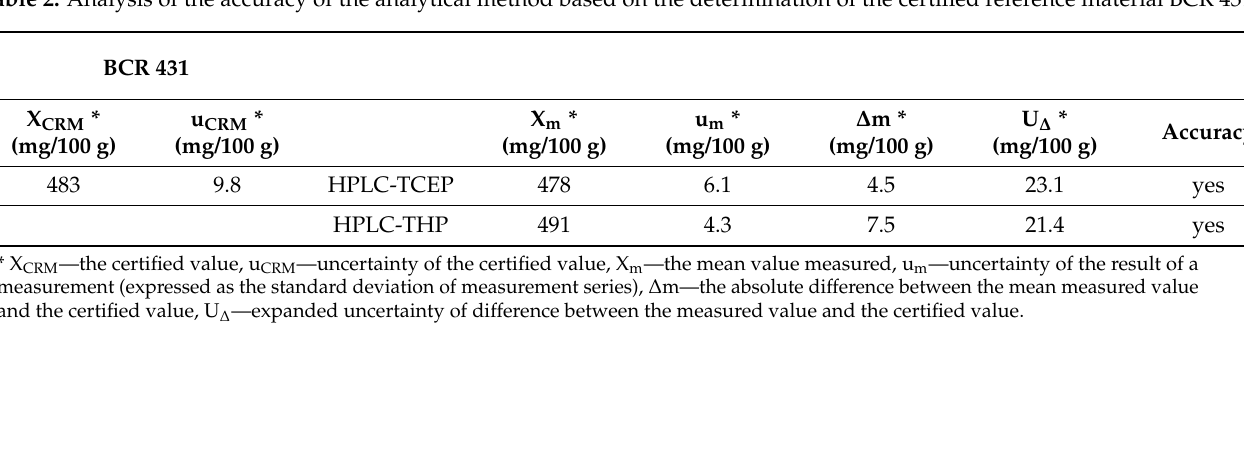
Table 2. Analysis of the accuracy of the analytical method based on the determination of the certified reference material BCR